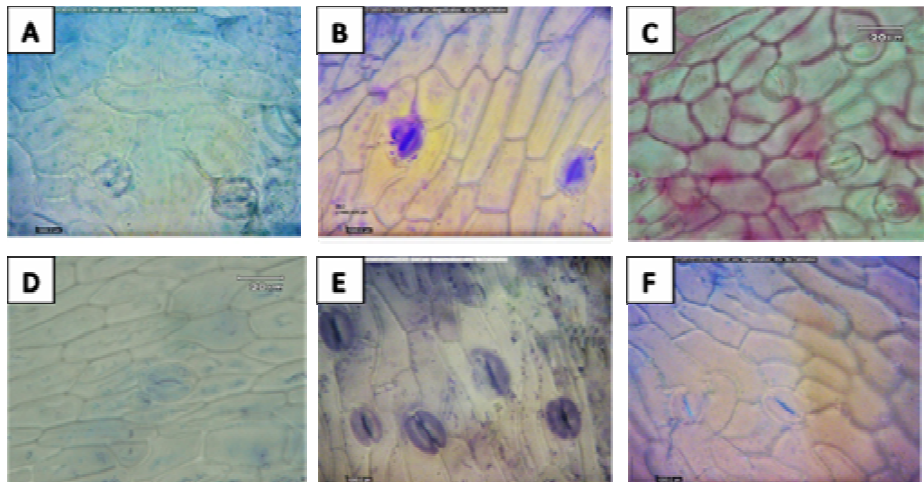
Fig. 5. Upper epidermis in : (A): O. acanthium ; (B) : O. armenum ; (C) : O. carmanicum; (D) : O. carduchorum; (E) : O. leptolepis; (F): O. heteracanthum . (Scale bar=20 µm; X= 400)